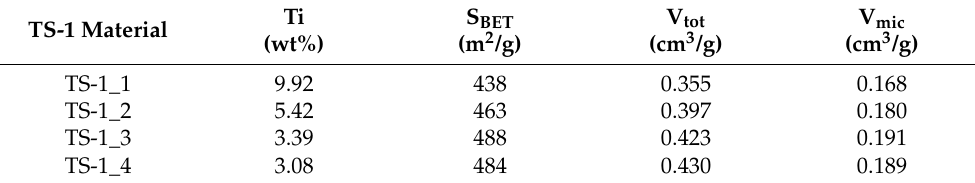
Table 1. The Ti content and textural parameters of the TS-1